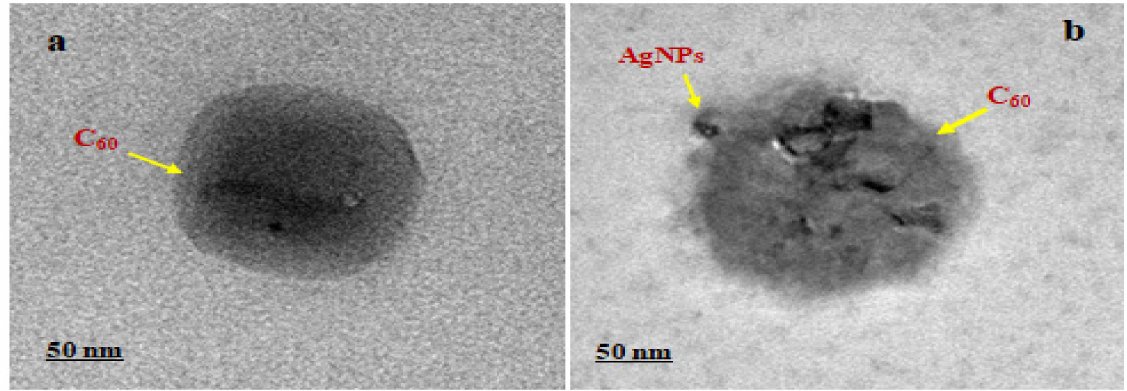
Figure 4. ( a ) HR-TEM micrograph of C 60 molecule; ( b ) C 60 -AgNPnanocomposites, the deposits of AgNPs over the surface of C 60 molecule could be seen; indicated by